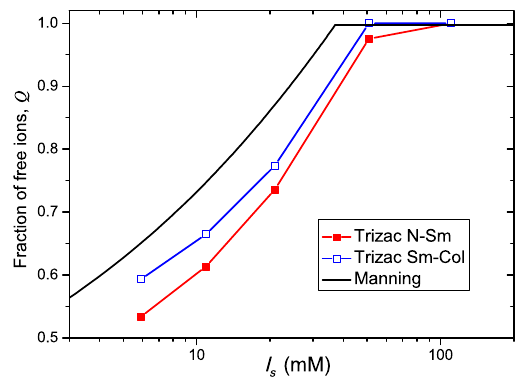
FIG. 2. Fraction of free ions Q as a function of the added salt I s obtained from calculations of Manning [49] (black line) and Trizac et al. [53] (open and full